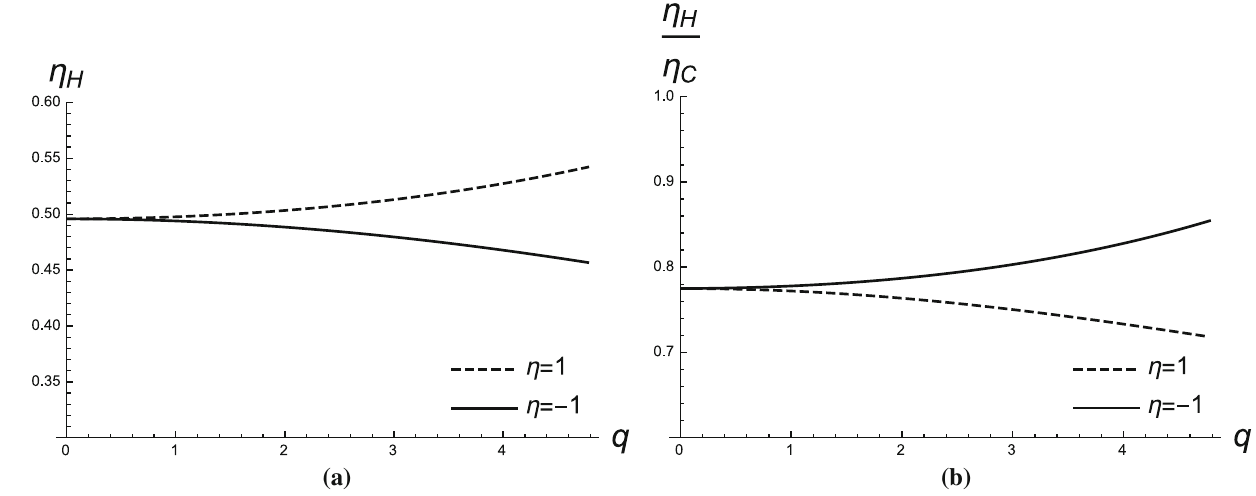
Fig. 4 A specific example with the parameters chosen as P 1 = 2 , P 4 = 1 , S 1 = 5 , S 2 = 10. a The heat engine efficiency η vs. q . b The ratio η/η C vs.